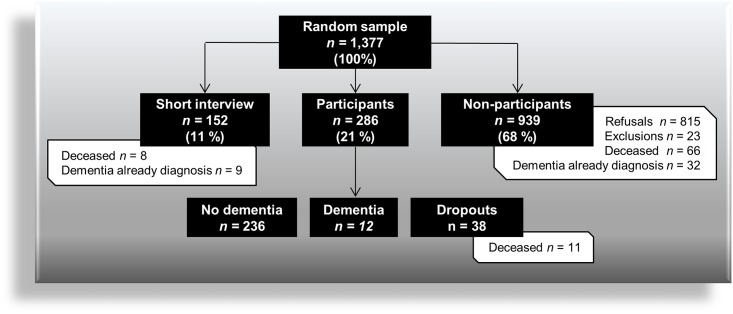
Flow chart showing participation rates and prevalence of dementia observed in the MémoVie cohort study.